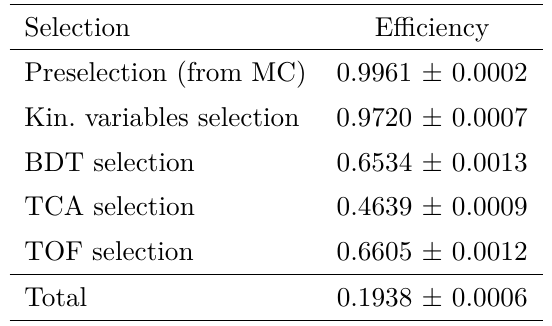
Table 4 . Signal selection efficiencies with statistical uncertainties. Correlations are accounted for in evaluating the total efficiency